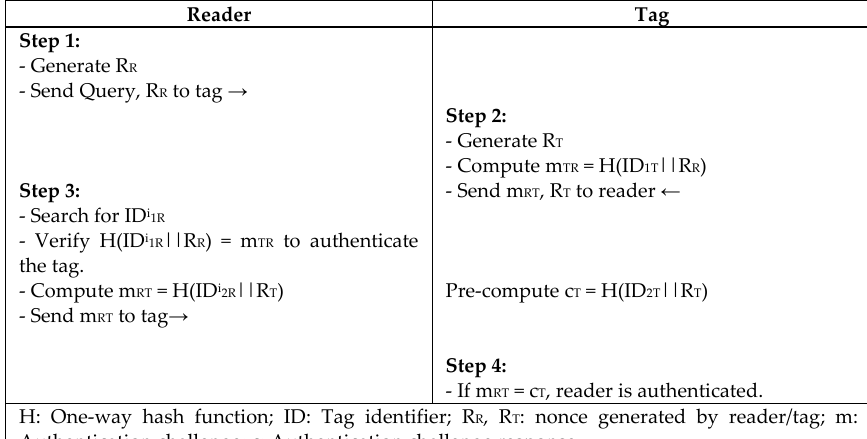
Figure 13. Efficient Passively-Untraceable Authentication Protocol (EP-UAP) by K. Lee. To defend against a desynchronization attack, Rahman and Ahamad [33] proposed a Desynchronization attack-resistant Robust Authentication Protocol (DRAP) in the wireless identification and sensing platforms (WISP), where RFID technology is combined with sensor nodes.